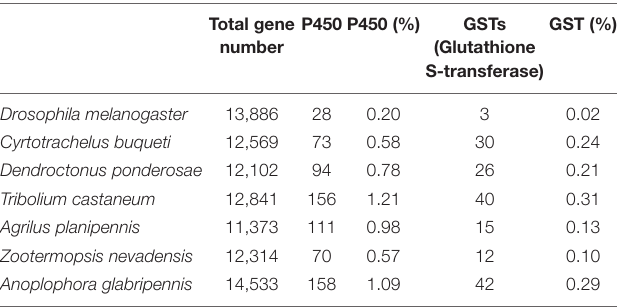
TABLE 6 | Identification and comparative analysis of detoxification enzyme gene between Cyrtotrachelus buqueti and other insect genomes. Total gene P450 P450 (%) GSTs number (Glutathione